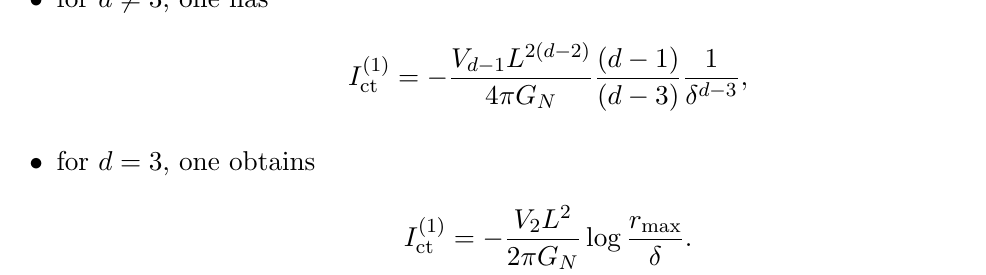
Figure 3 . The WDW patch for an eternal black hole at times t < t second regularization. Moreover, in contrast to (cid:12)gure 1, in this case, the WDW patch has an extra spacelike boundary which is a part of the past